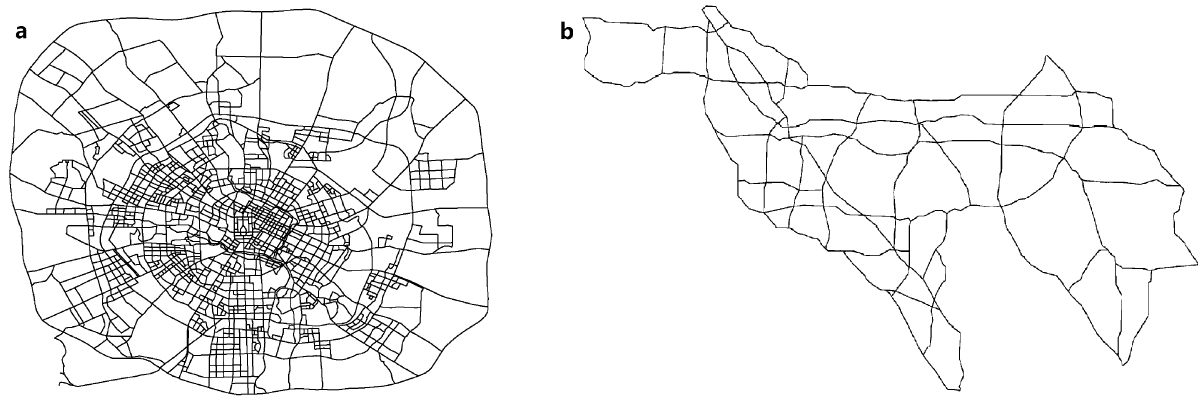
Figure 1. Two road networks used. ( a ) Urban road network of Chengdu (Figure courtesy of Guo et al. 7 ). ( b ) Freeway network of